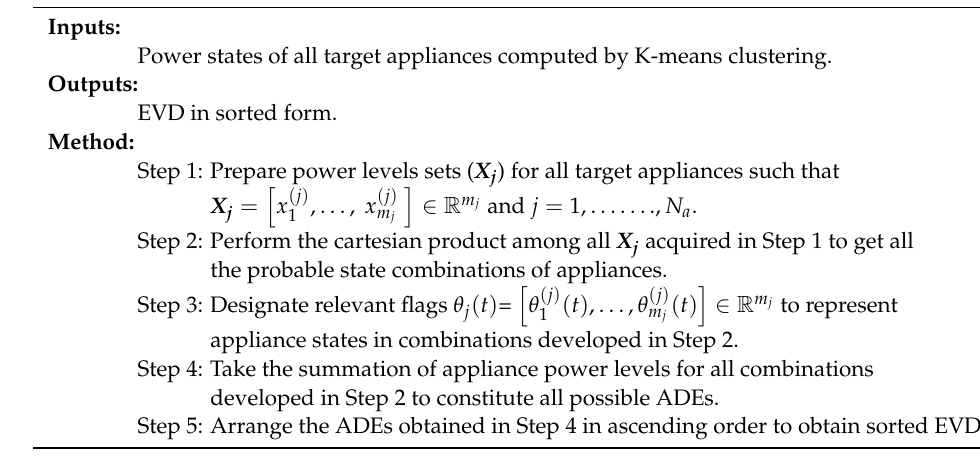
Algorithm 1: Proposed Algorithm for EVD